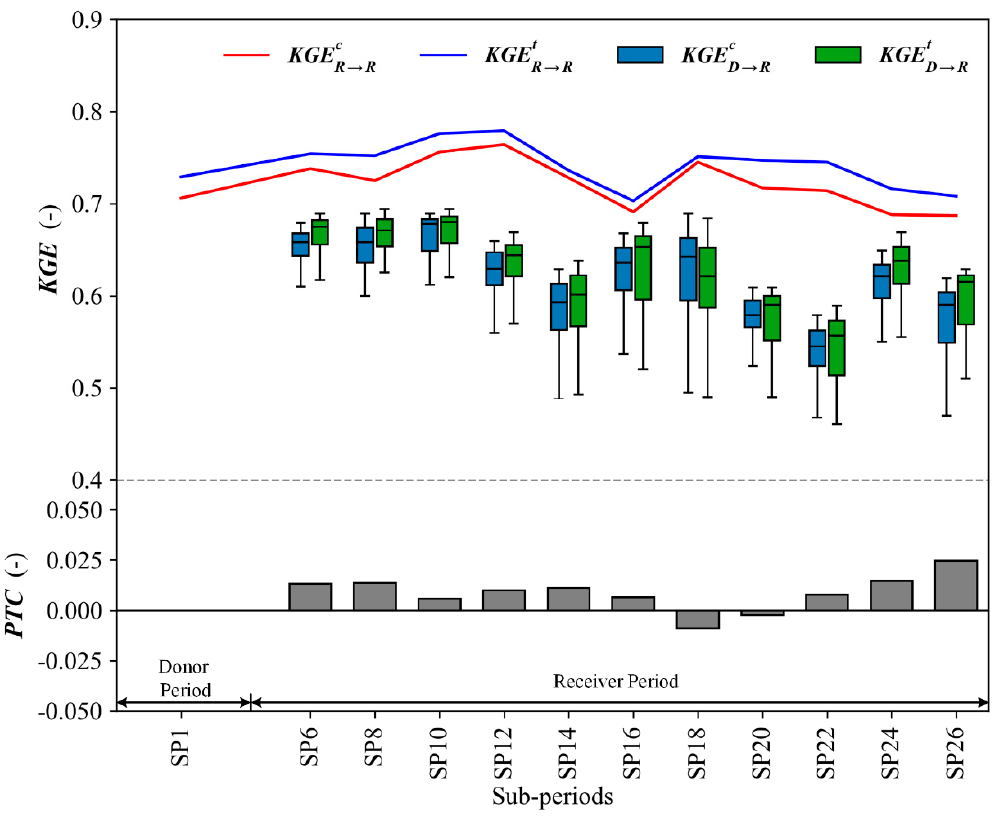
Figure 9. Comparison of streamflow simulation performance in terms of KGE when parameter sets calibrated during P1 are transferred to other sub-periods (SP6–SP26) for the GR4J model and the GR4J-T model in Tuojiang Basin.